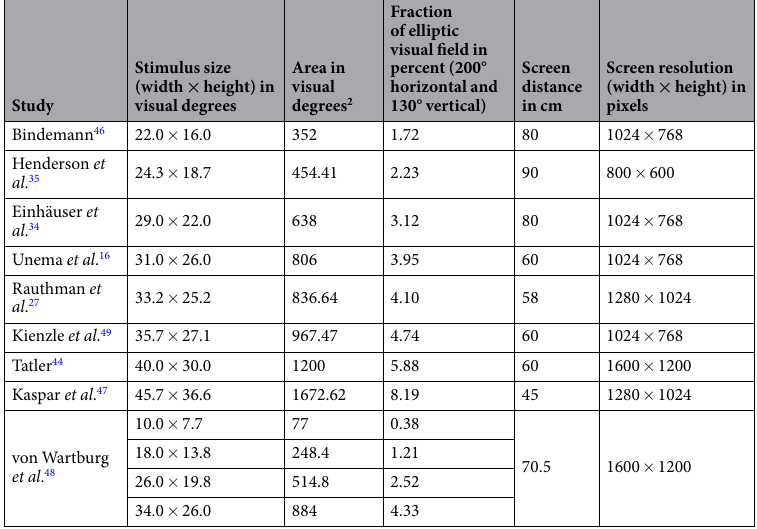
Table 1. Exemplary list of stimulus size and resolution of the display screen used in some recent eye-tracking studies. The stimulus size in visual degrees depends on the distance between participant and screen. Also, the approximate fraction of the (elliptic) visual field area covered by the stimulus is